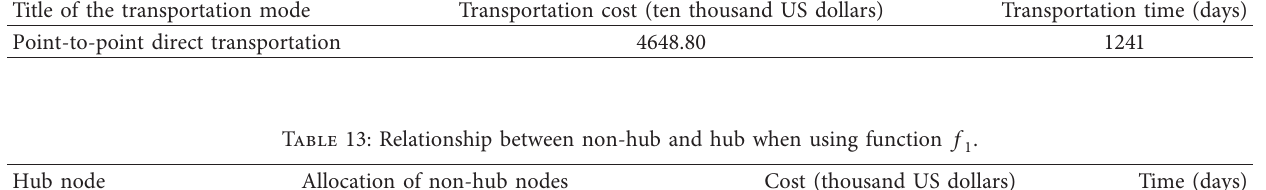
Table 12: Operating cost and time index in point-to-point direct transportation mode.